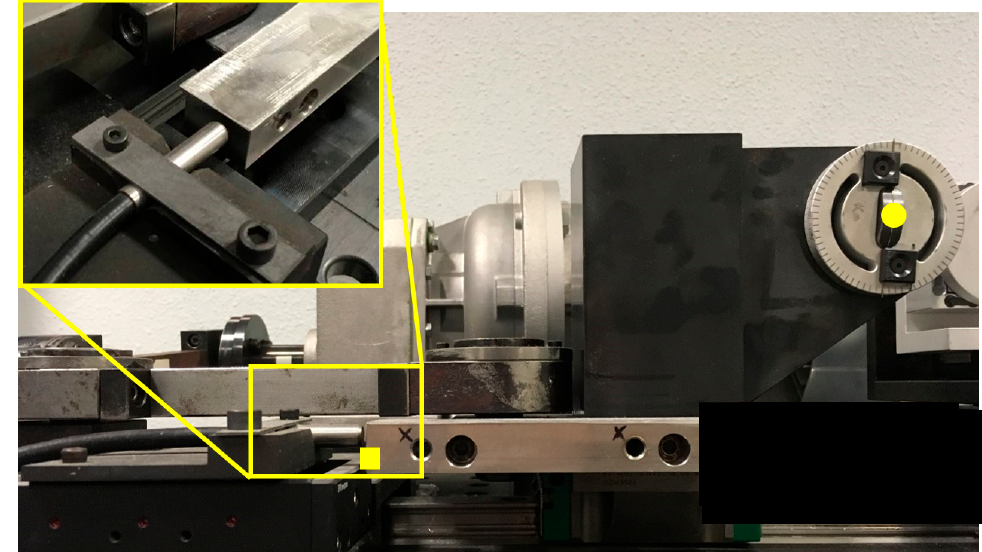
Figure 3. Detail of the displacement measurement module. Note that the displacement is measured remotely where the compliance of the contact system could influence the measurements.